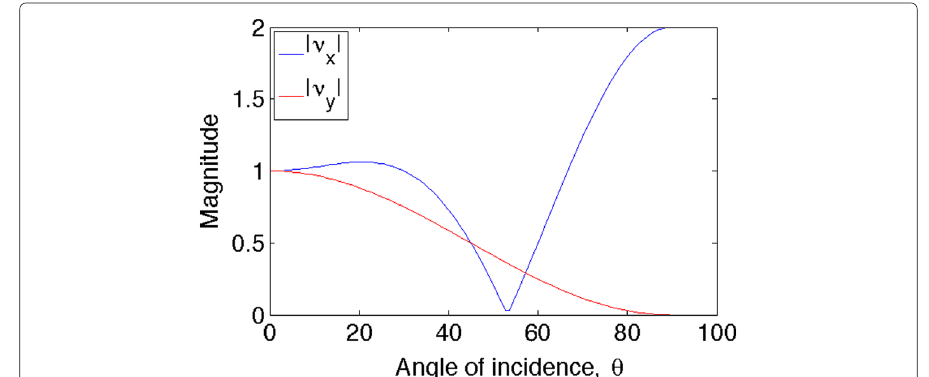
Fig. 11 Comparison of the second order curvature term coefficients magnitudes, |ˆ ν x | and |ˆ ν y | . It can be seen the magnitude of ˆ ν x is greater than ˆ ν y for all angles except the range 45 ◦ < θ < ∼ 57°